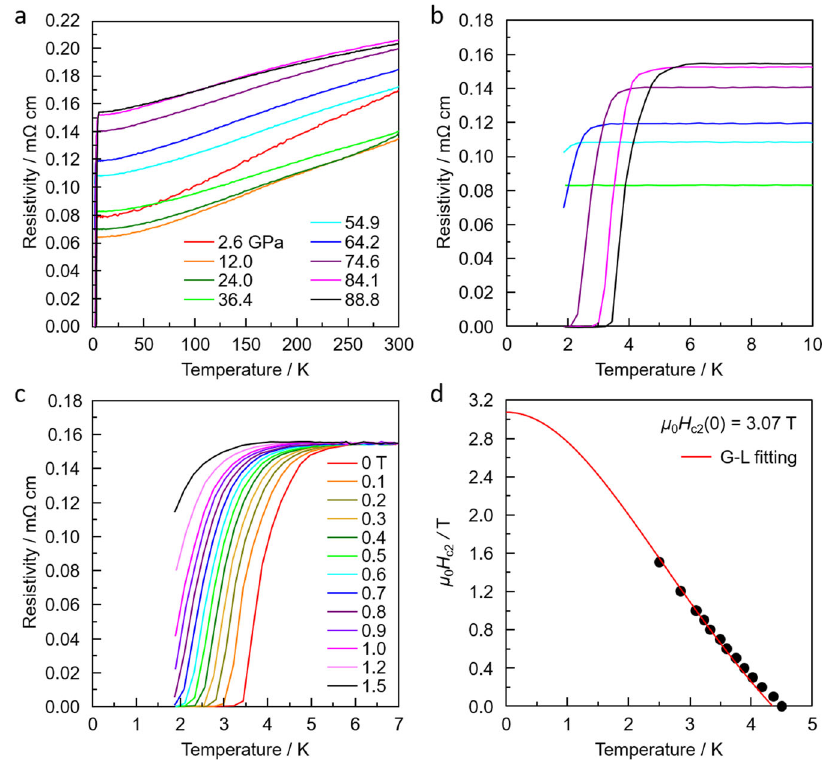
Fig. 2 Electrical transport proerties of Pt 2 HgSe 3 under high pressure. a Electrical resistivity of Pt 2 HgSe 3 as a function of temperature for various pressures. b Temperature-dependent resistivity of Pt 2 HgSe 3 in the vicinity of the superconducting transition. c Temperature dependence of resistivity under different magnetic fi elds for Pt 2 HgSe 3 at 88.8 GPa. d Temperature dependence of upper critical fi eld for Pt 2 HgSe 3 at 88.8 GPa. Here, T c is determined as the 90% drop of the normal state resistivity. The solid lines represent the fi ts based on the Ginzburg – Landau (G-L)